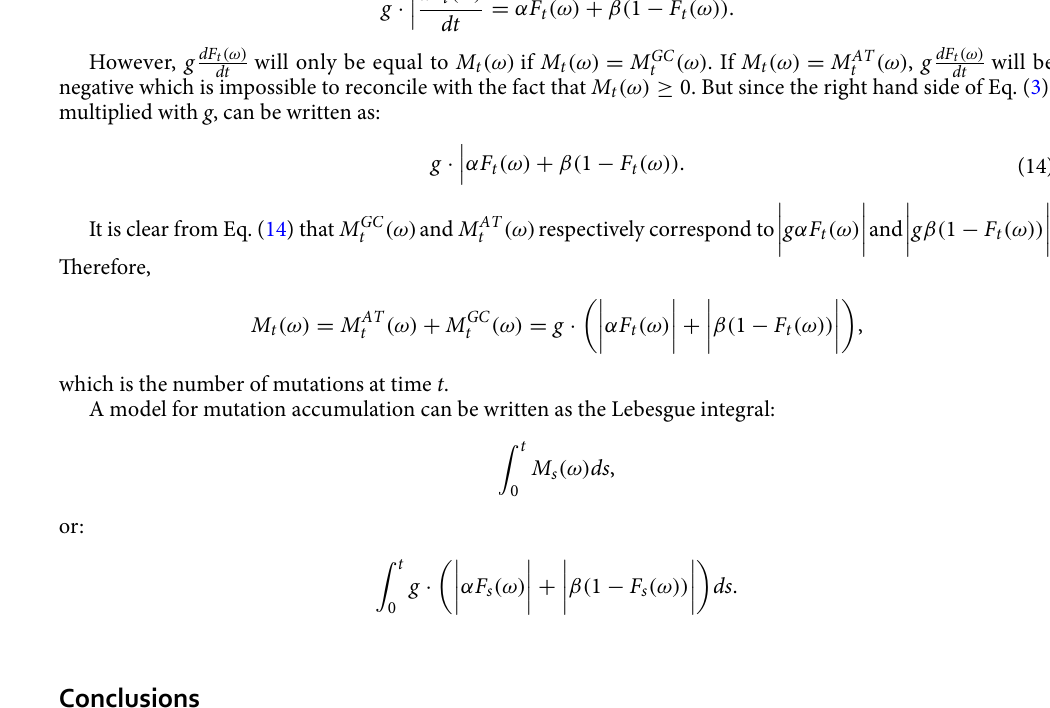
√ 1 2 , Panel P3: p = 2 . The red = 2 , Panel P2: p